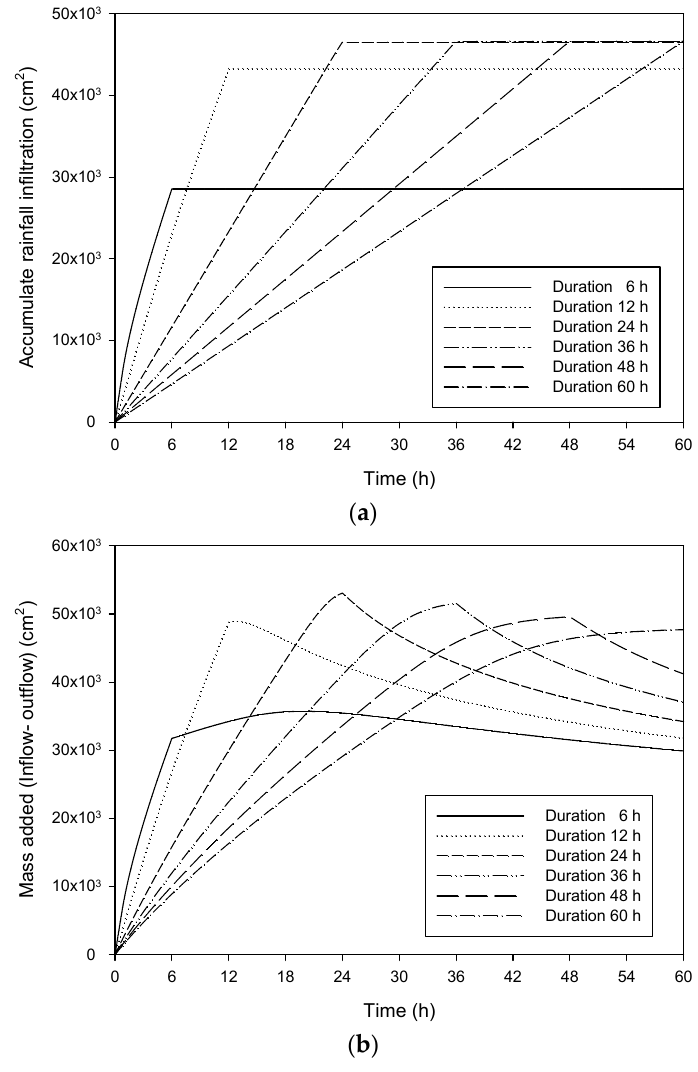
Figure 7. Slope surface inflow ( a ); and mass added ( b ) for different duration with uniform rainfall of 400 mm.